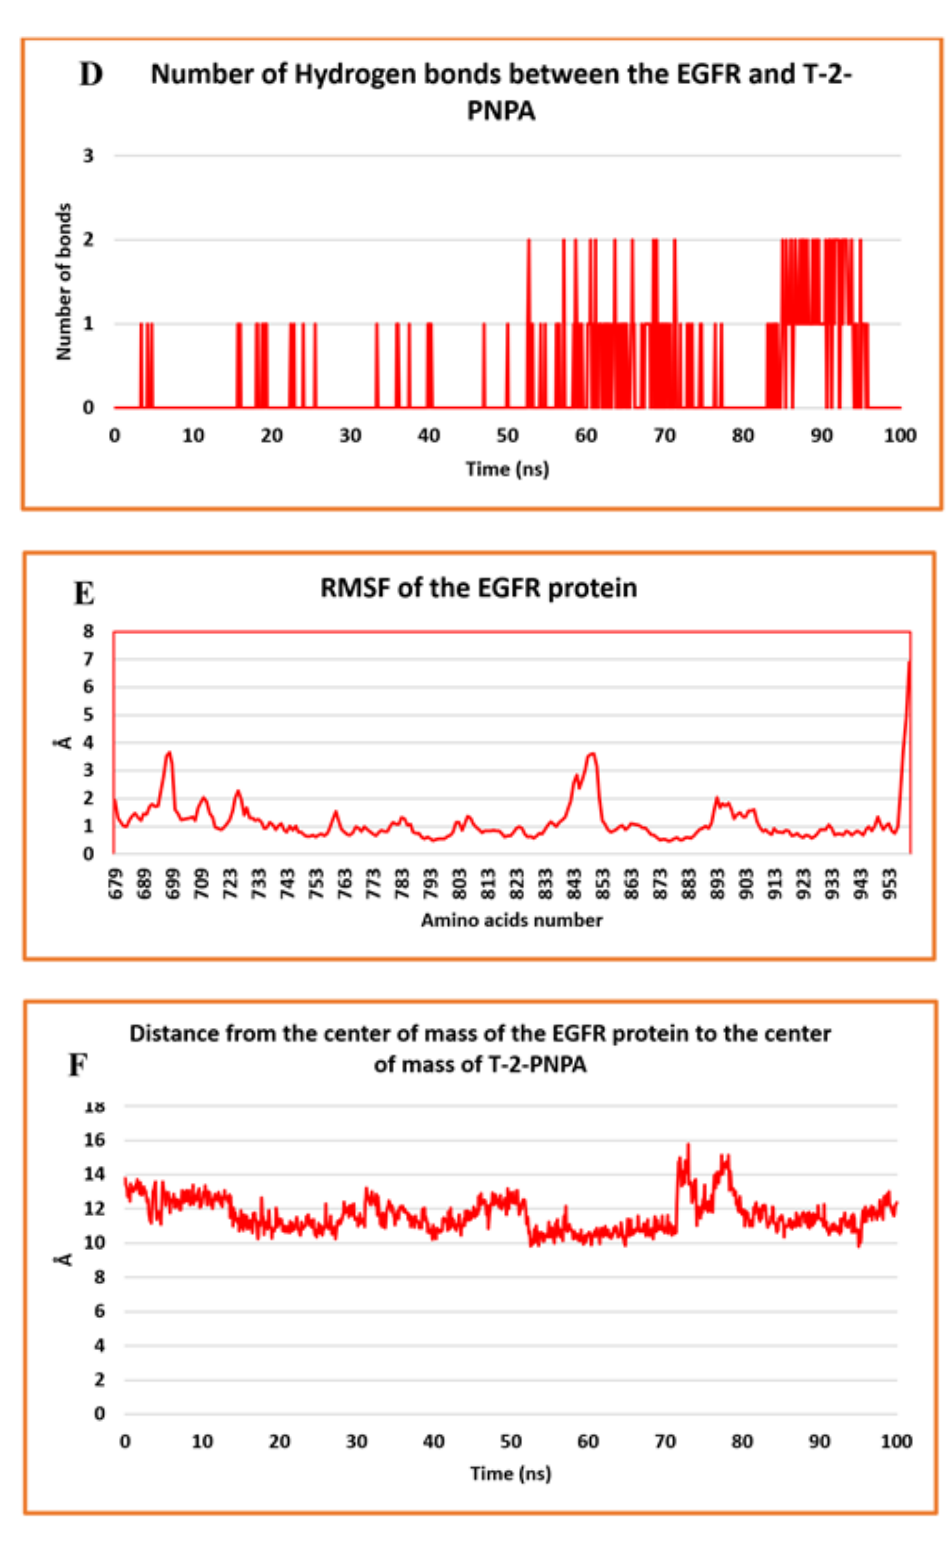
Figure 7. MD simulation’s findings computed from the trajectory. (A) RMSD: EGFR (blue), T-2- PNPA (red), and EGFR – T-2-PNPA complex (green), (B) RoG (C) SASA (D H Bs’ number changes (E) (red), and EGFR– T-2-PNPA complex (green), ( B ) RoG ( C ) SASA ( D ) HBs’ number changes ( E ) RMSF, RMSF, and (F) Center of Mass distance between the T-2-PNPA and EGFR. and ( F ) Center of Mass distance between the T-2-PNPA and